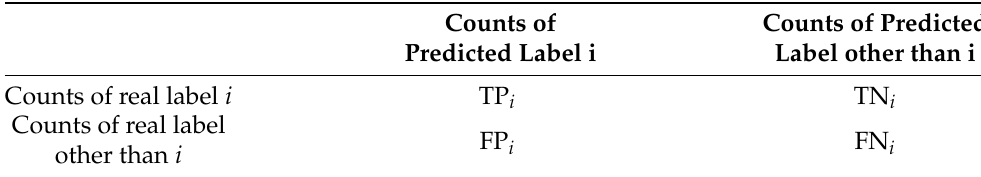
Table 6. Confusion matrix for each fault